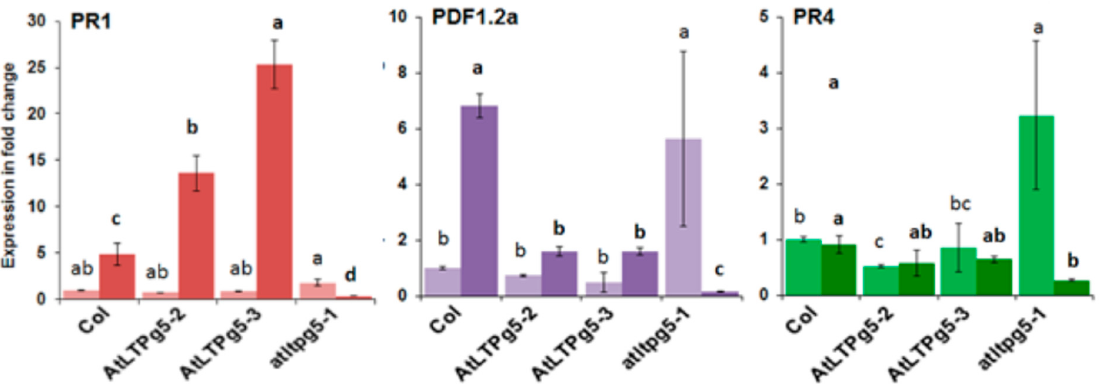
Figure 12. Expression of PR genes in response to P. syringae pv tomato DC3000 in LTPg5 overexpression lines and mutant. The RNA was extracted from inoculated two-week-old seedlings on plates. The seedlings without root were harvested at 0 hpi and 24 hpi for three biological replicates ( n = 3) for RNA isolation and qPCR. The light bars show expression in different genes at 0 hpi, while the dark bars display the expression at 24 hpi. The data were analysed for significance difference using ANOVA ( p < 0.05) and LSD for 0 hpi and 24 hpi separately. The values are means ± SE. Different letters indicate significant differences for the expression of genes among the lines at different timepoints.